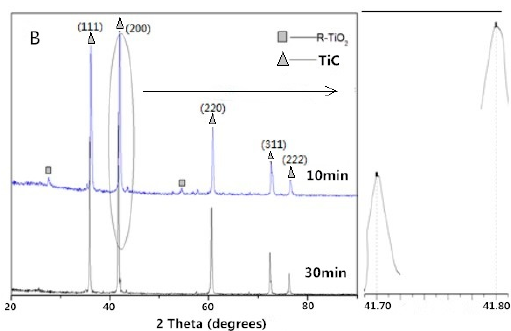
Figure 3. XRD patterns of the samples synthesized at ( A ) 1300 °C and ( B ) 1400 °C.